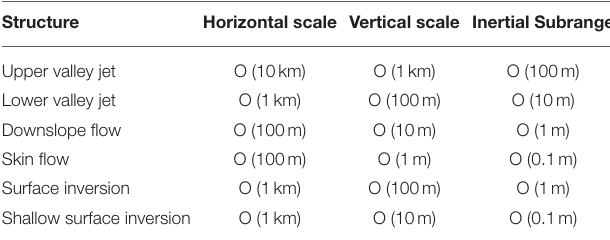
TABLE 1 | Valley flow structures: order of magnitude of sizes and of related inertial subrange.